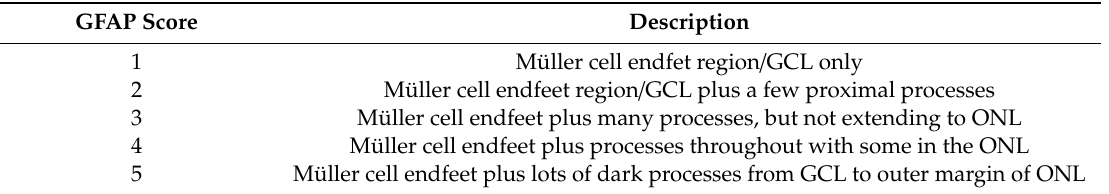
Table 2. Scoring system based on the extent of GFAP